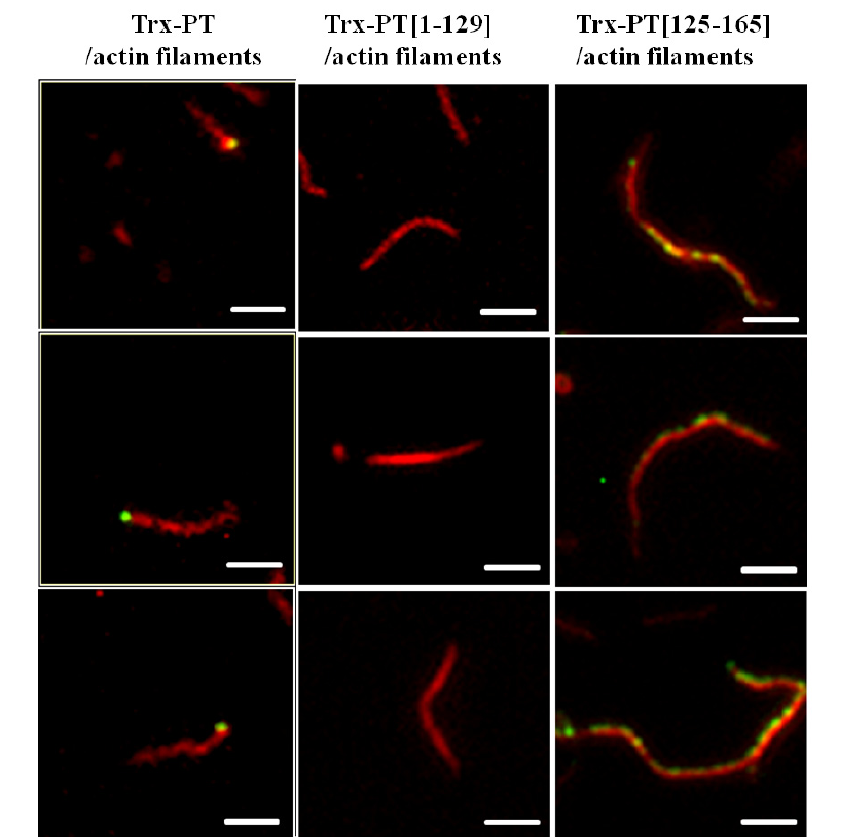
Figure 3. Single filament binding assay. Trx-PT, trx-PT(1–129) or trx-PT(125–165) was conjugated with Alexa-488, which emitted green fluorescence after excitation. Actin filaments were labeled with rhodamine-phalloidin, which emitted red fluorescence after excitation. Alexa-488-labeled trx-PT(1–129) does not bind to actin filaments. Alexa-488-labeled trx-PT(125–165) binds to the sides of actin filaments. Alexa-488-labeled trx-PT binds to the end of actin filaments. Under assay conditions, 96% of Alexa-488-labeled trx-PT were localized at the filament end ( n = 52); 98% of Alexa-488-labeled trx-PT(125–165) were bound to the sides of actin filaments ( n = 92). The bar represents 3 μ